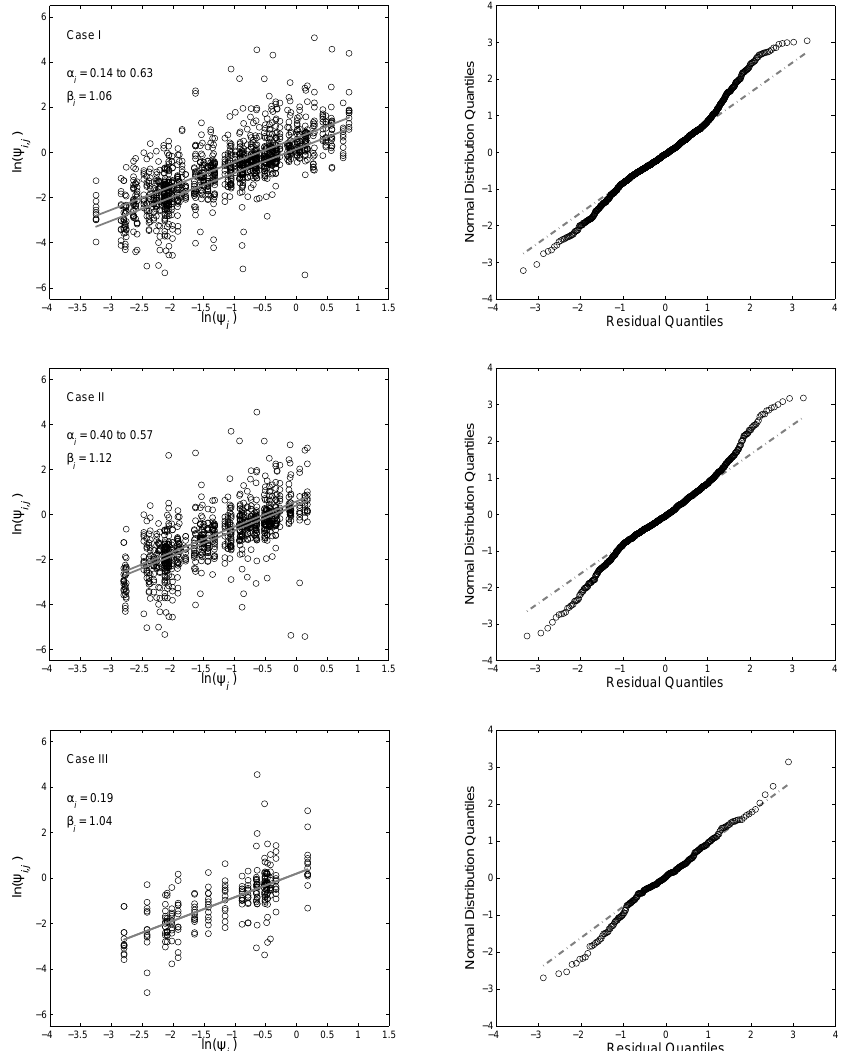
Fig. 6. Left: Plot of ln( ψ i,j ) versus ln( ψ i ) for Cases I to III. To plot the lines, we used values of α i (intercept) and β i = β (slope) obtained from our statistical analysis, but assumed γ i ln( a ′ j )=0 ; see equation (8). The bot- tom line in a plot represents the minimum value of α i among events while the top line represents the maximum value of α i . Right: QQ plot of residuals obtained from statistical analysis results.